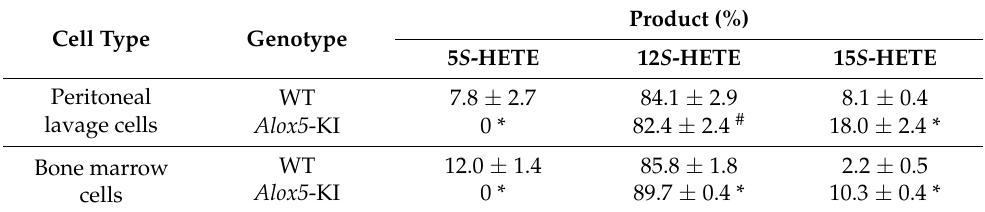
Table 1. Composition of the major oxygenation products formed during the ex vivo activity assays using different cell preparations from Alox5 -KI mice and wildtype controls. Cell preparation, activity assays and RP-HPLC analyses were carried out as described in the legend to Figure 2. The sum of the major oxygenation products was set at 100% and the relative shares of 15-HETE, 12-HETE and 5-HETE were calculated. Four different animals ( n = 4) were analyzed for each genotype. To quantify the extent of product formation we subtracted the sizes of the chromatographic peaks (area units) of the no-cell control incubations from the corresponding peak of the cell incubations. In some cases, we found that the 5-HETE levels in the cell incubations were smaller than those in the no-cell control incubations. In these cases, we set the differences to 0. * Comparison (two-sided t -test) of the relative shares of each product (12 S -HETE, 15 S -HETE, 5 S -HETE) between Alox5 -KI animals and wildtype controls revealed highly significant ( p < 0.01) differences. # The difference in 12 S -HETE formation by peritoneal lavage cells (84.1 ± 2.9% 12 S -HETE formation for wildtype cells vs. 82.4 ± 2.4% 12 S -HETE formation for Alox5 -KI cells, p = 0.316) did not reach the level of statistical significance. Product (%) Cell Type Genotype 5 S -HETE 12 S -HETE 15 S -HETE Peritoneal lavage